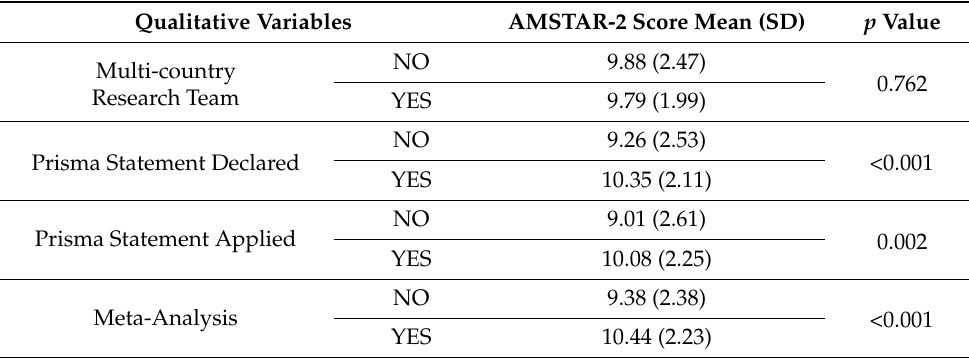
Table 2. Univariate Analysis of the AMSTAR-2 score vs. Qualitative